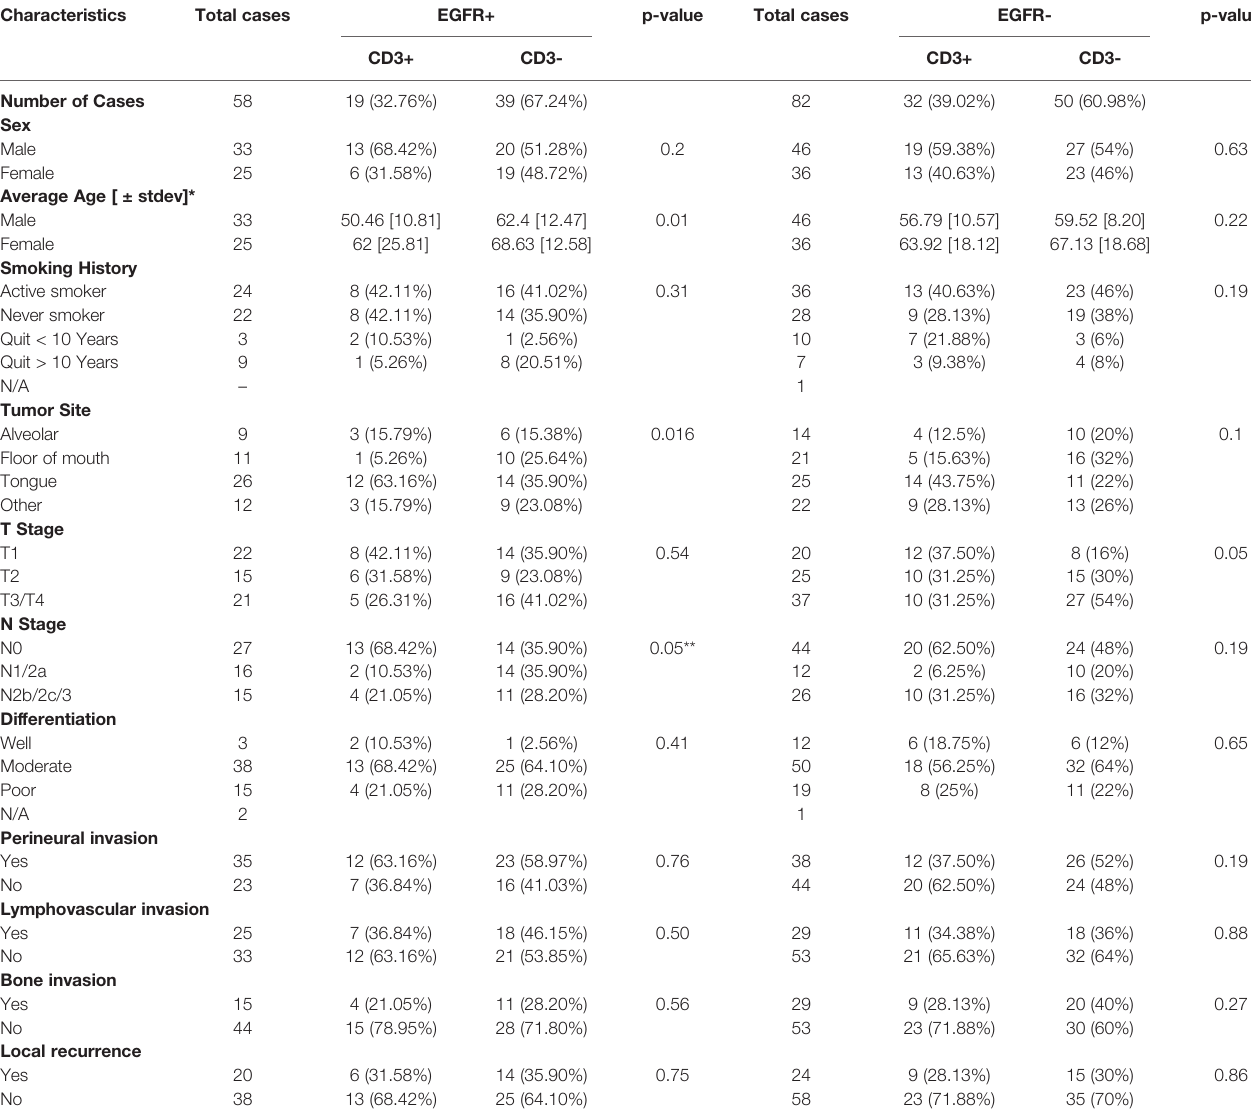
TABLE 3 | Clinicopathological features of patients based on EGFR/CD3 status.